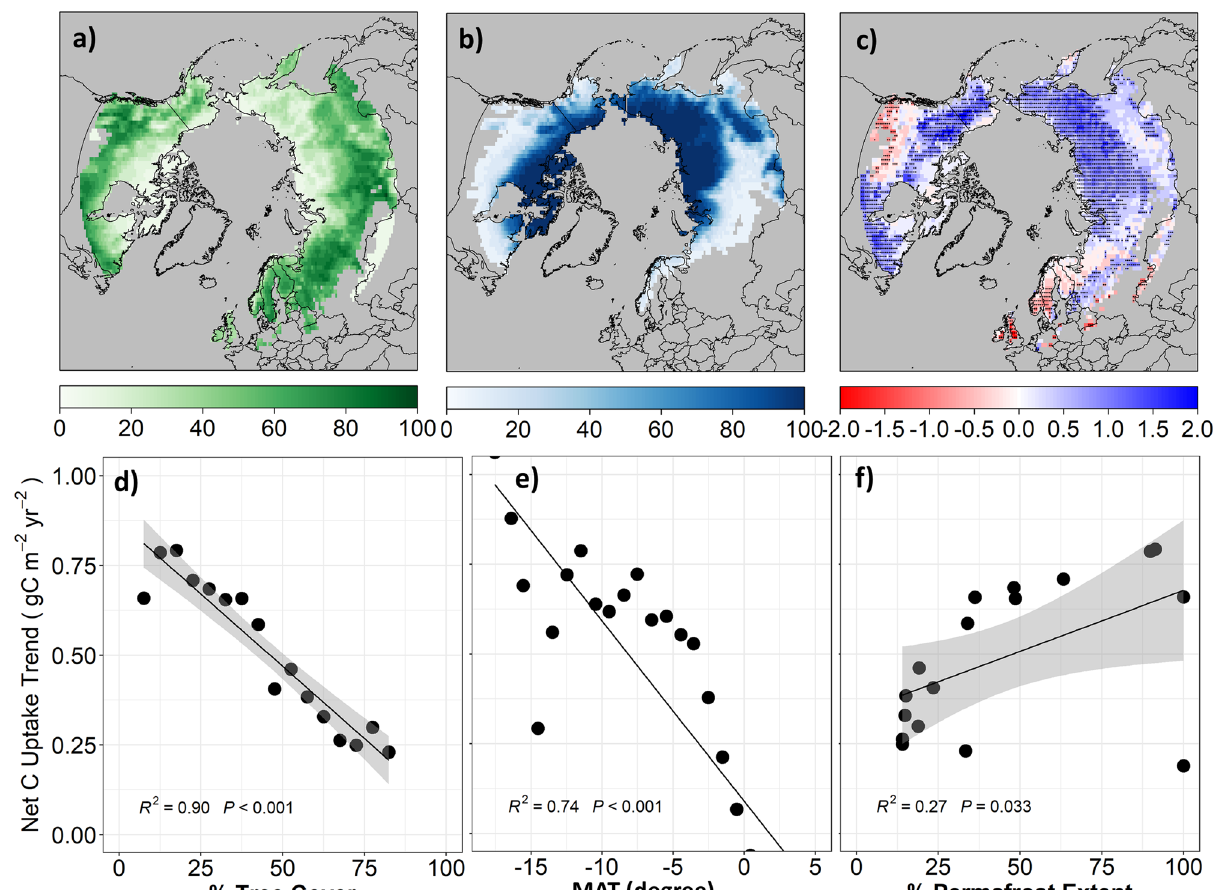
Fig. 1 | Net CO 2 uptake is increasing faster in regions of lower tree cover and greater permafrost extent from 1980 to 2017 across the NHL (>50°N) according toanensembleof ACIs. The maps show regional patterns of a percent treecover(%TC)basedon35-year(1982-2016)TClayersobservedbytheAdvanced Very High-Resolution Radiometer (AVHRR) 42 ; b percent of permafrost extent (%P) based on the average over 1997 – 2017 from European Space Agency (ESA) Climate